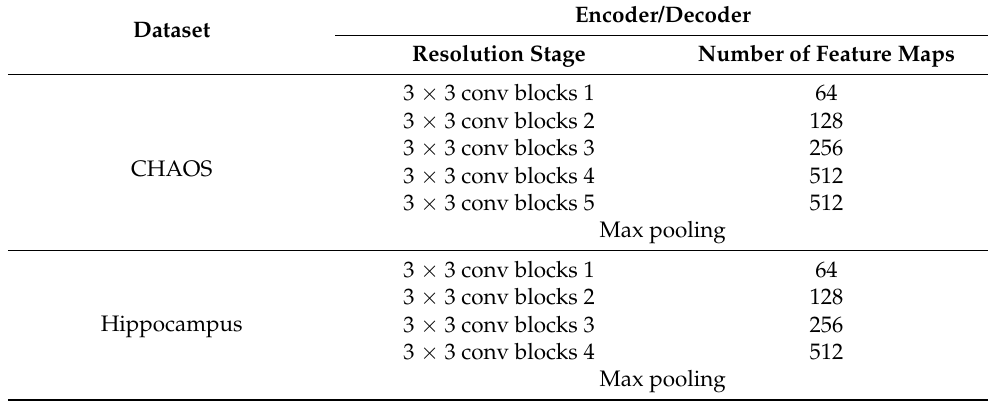
Table 2. The configurations of Segnet encoder and decoder layers in our experiments on CHAOS and hippocampus